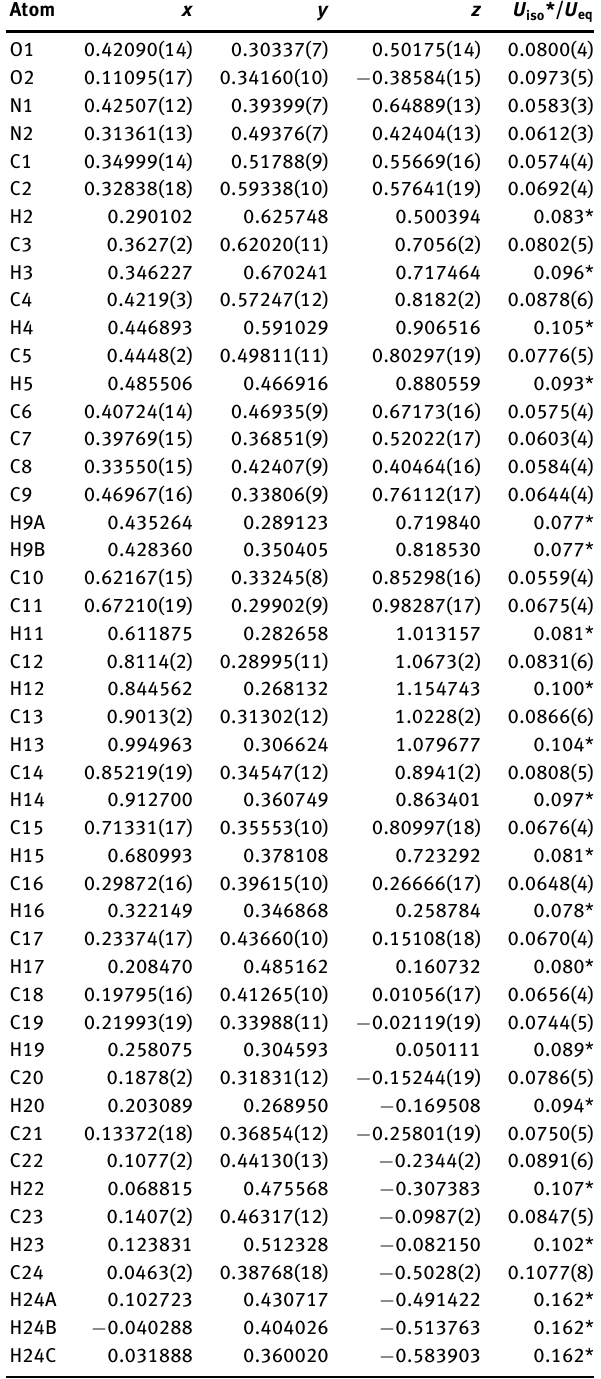
Table 2: Fractional atomic coordinates and isotropic or equivalent isotropic displacement parameters (Å 2